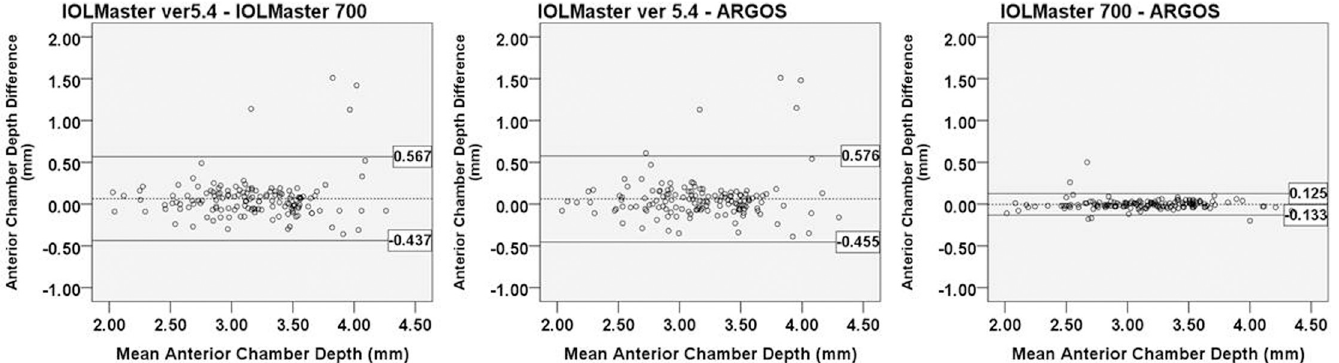
Fig 3. Bland-Altman plot for the ACD measurements of each device. The mean difference is indicated by the dashed lines, and 95% LoA is indicated by the solid line. Comparison of IOLMaster ver. 5.4 and IOLMaster 700 (A); IOLMaster ver. 5.4 and Argos (B); and IOLMaster 700 and Argos (C).